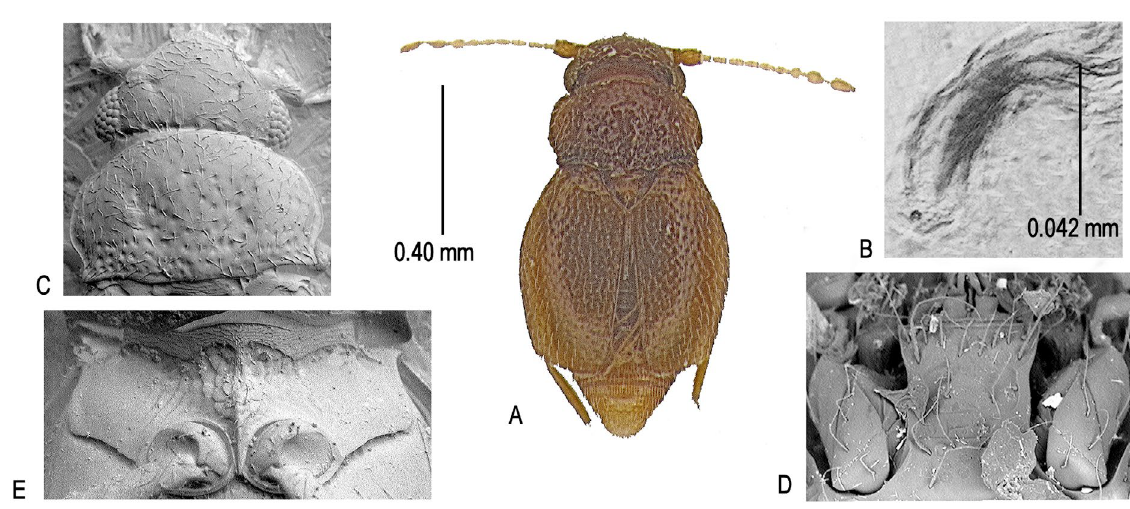
Fig. 4. Erro brookei sp. nov. A . Habitus. B . Aedeagus. C . Head and pronotum ×460. D . Mentum and submentum ×1420. E . Mesoventrum